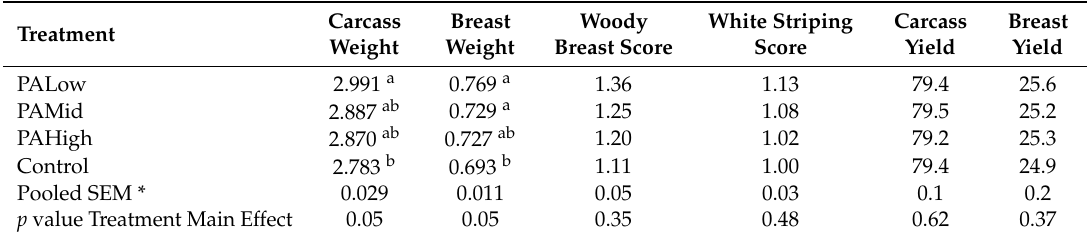
Table 8. Processing data: carcass weight (kg), breast weight (kg), woody breast score, white striping score, carcass yield (%), and breast yield (%) in Experiment